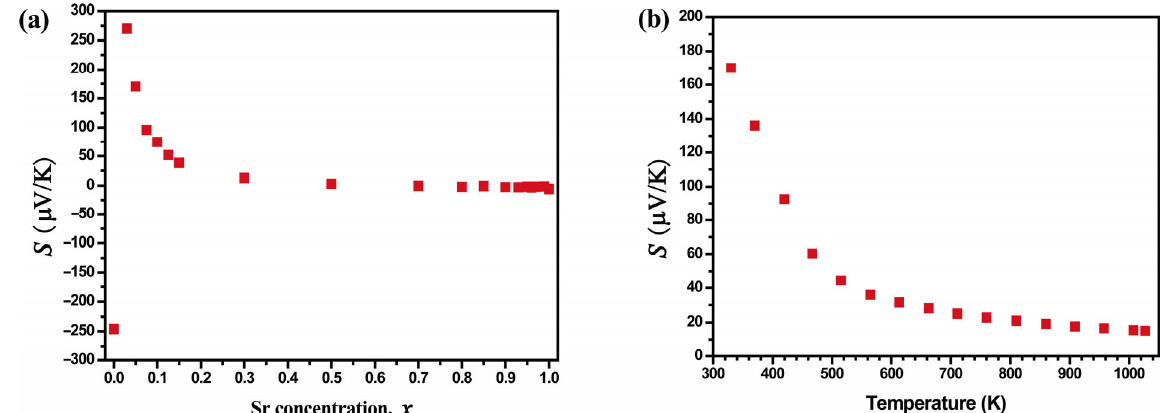
Fig. 8 Seebeck coefficient ( S ) for La 1– x Sr x CoO 3 with (a) 0 ≤ x ≤ 1 at 330 K and (b) x = 0.05 at different temperatures.